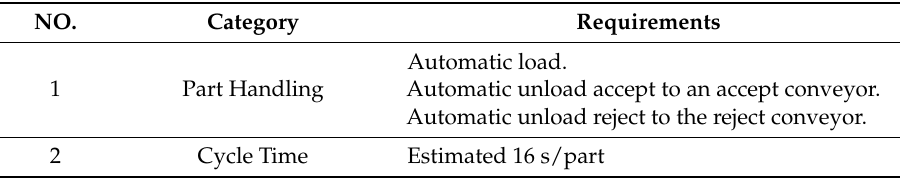
Table 3. Design requirements of the automatic sorting system.